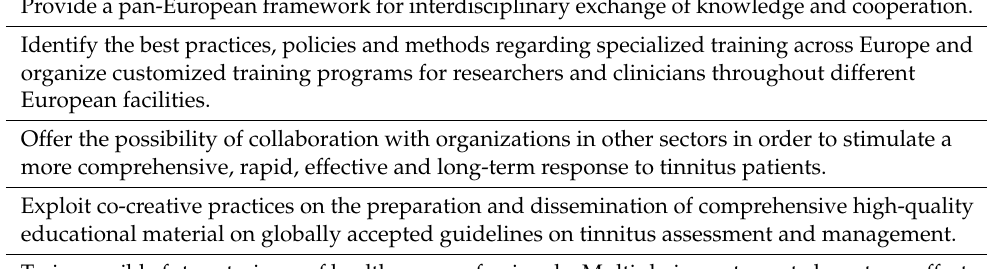
Table 1. Main objectives of